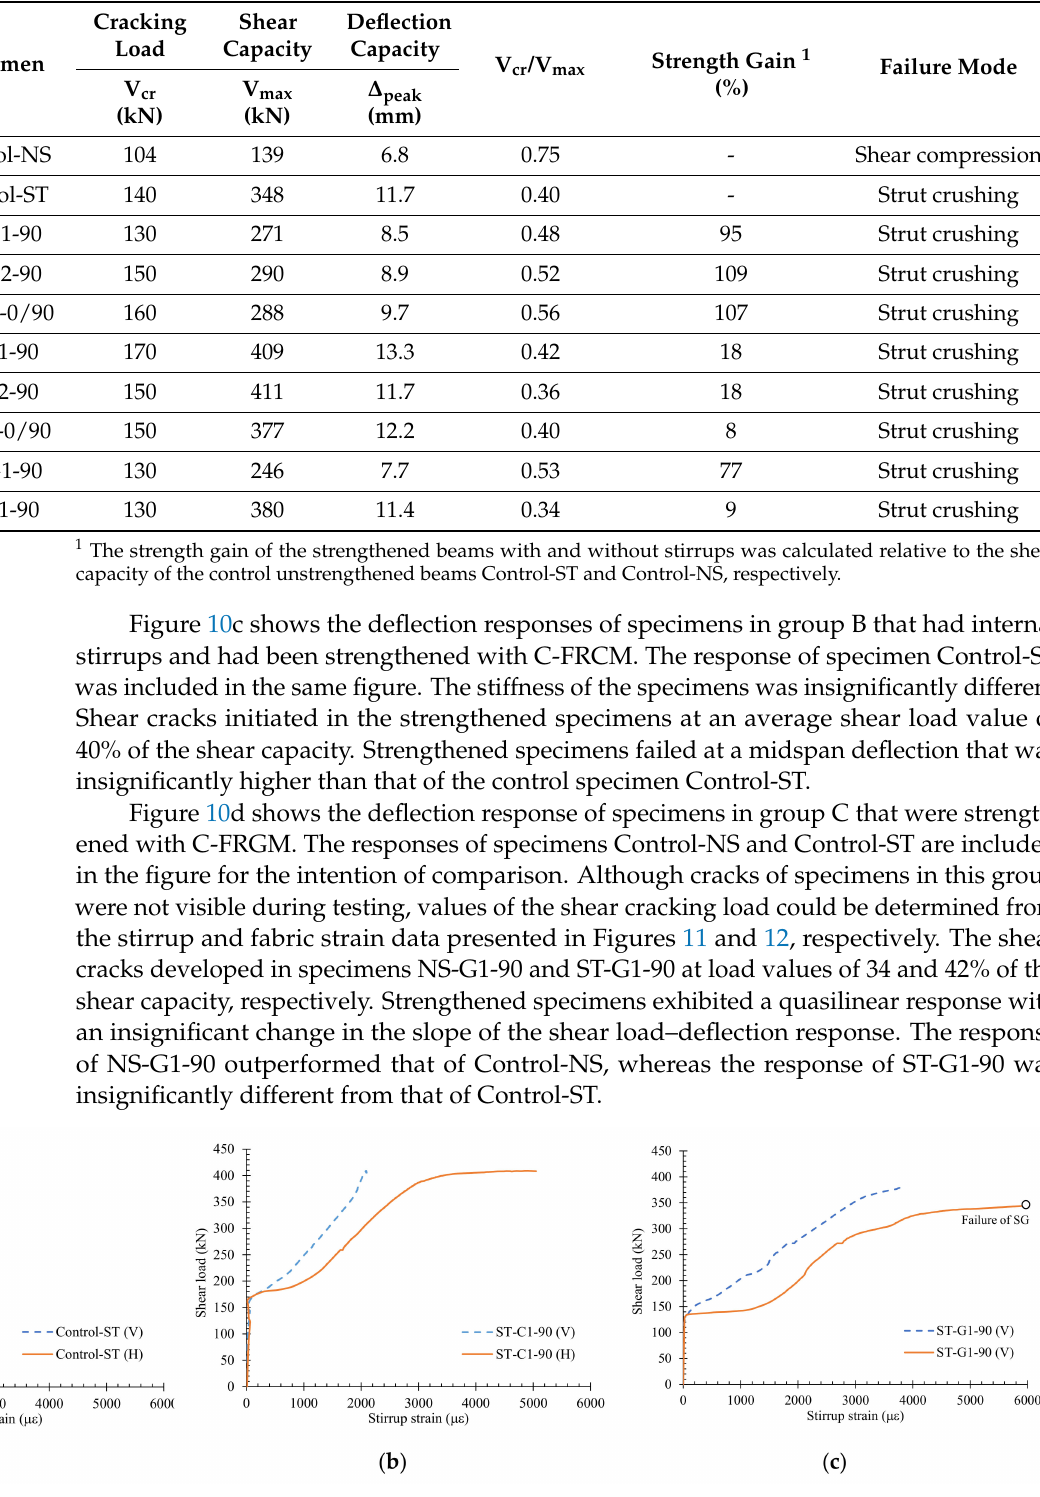
Figure 11. Typical stirrup strain response: ( a ) Control-ST; ( b ) ST-C1-90; ( c )